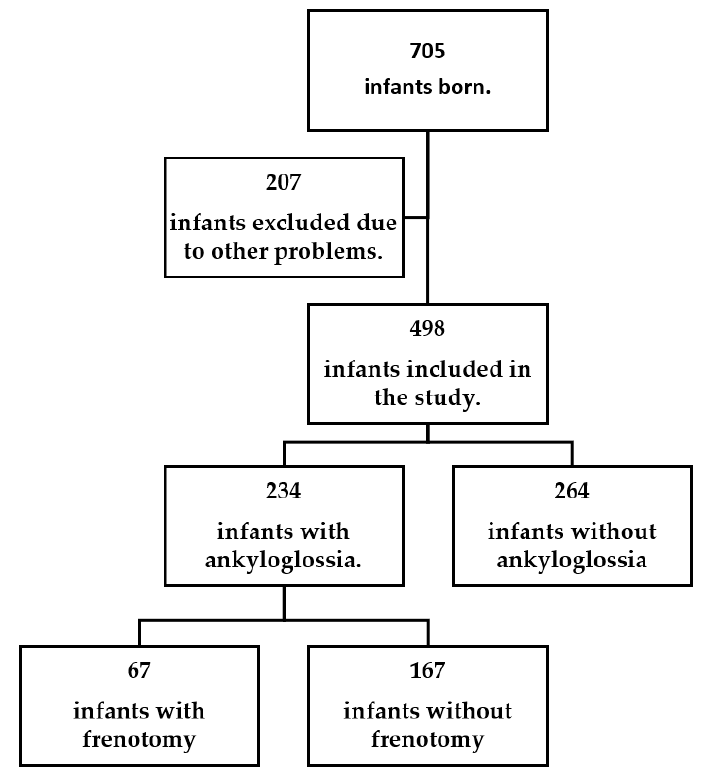
Figure 1. Patient